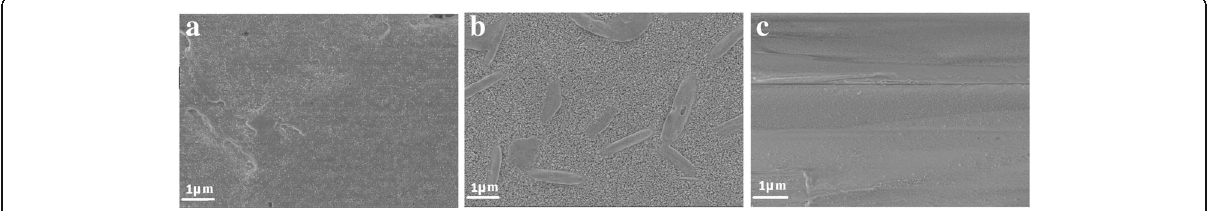
Fig. 6 SEM images of blade-coated films from the paste of powders prepared by a anti-solvent, b milling, and c spray